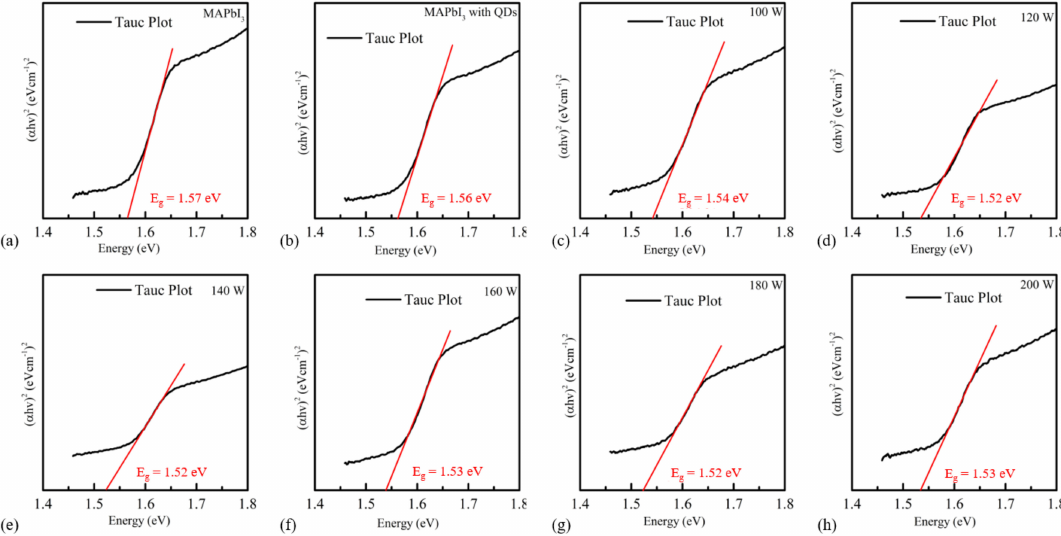
Figure 3. ( a – h ) Band-gap calculation for MAPbI 3 and composite perovskite film treated by APT at different